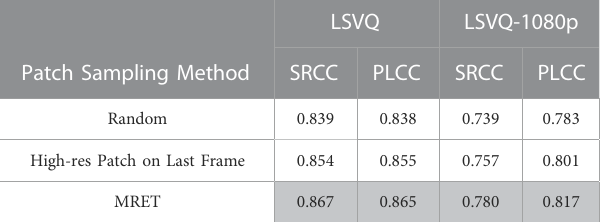
TABLE 4 Ablation for multi-resolution patch sampling method. Our fi nal method is marked in gray.